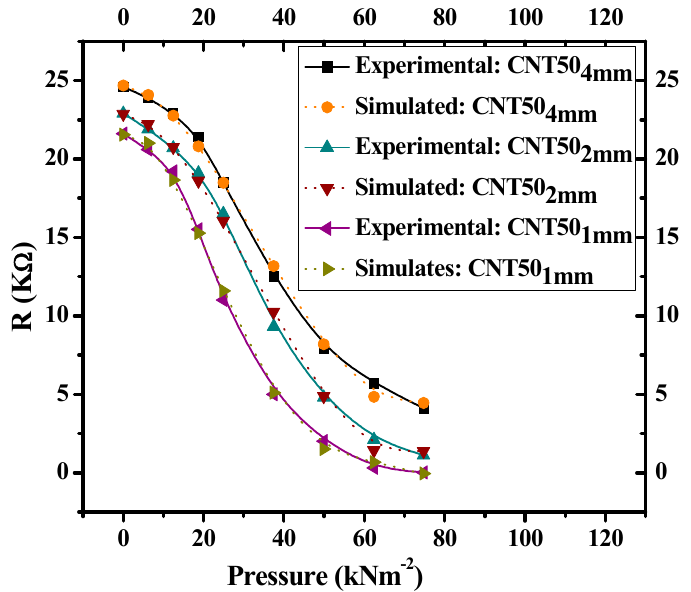
Figure 9. Resistance–pressure characteristics of experimental data (Figure 8) and simulated results (Equation (2)) for CNT–graphene composite-based piezoresistive pressure sensors with thicknesses of 1, 2 and 4 mm.